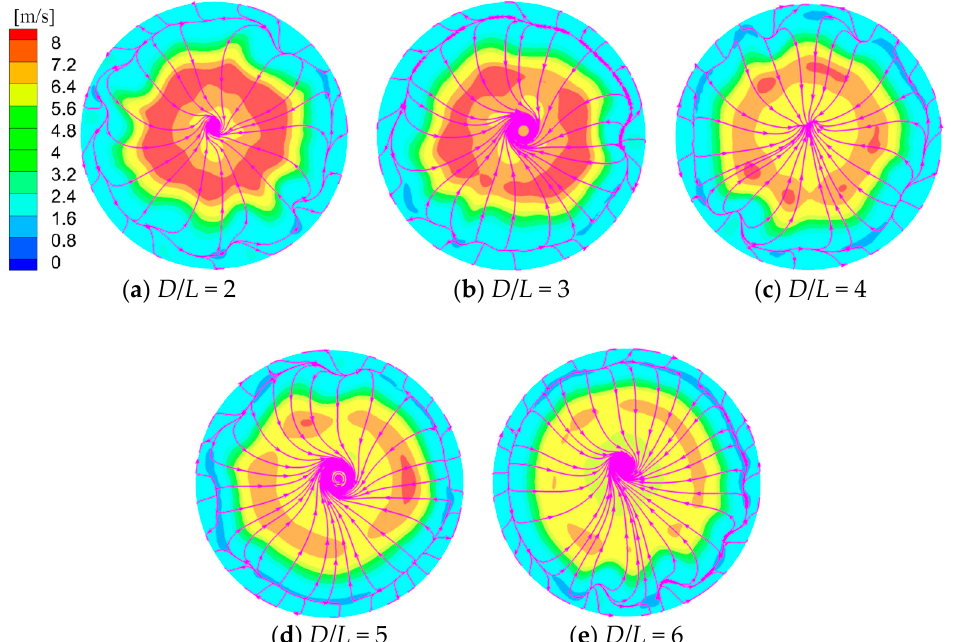
Figure 13. Cross-sectional velocity distributions and flow patterns at the pump inlet. ( a ) D/L = 2; ( b ) D/L = 3; ( c ) D/L = 4; ( d ) D/L = 5; ( e ) D/L =